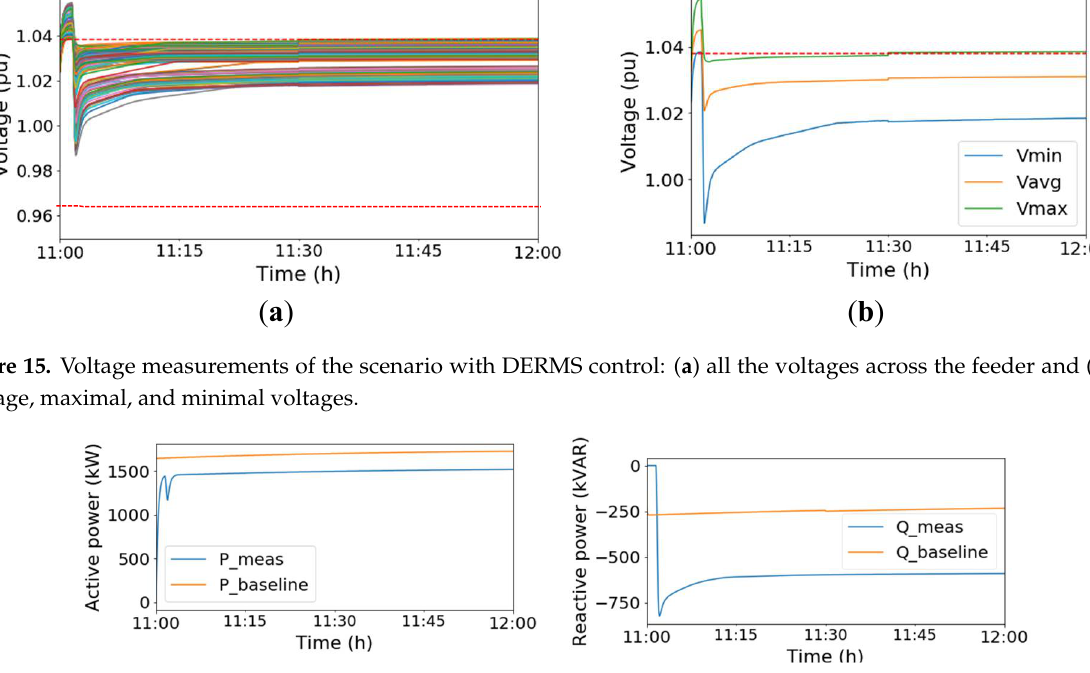
Figure 14. Components of the experimental setup of the HIL platform. Photos by NREL.